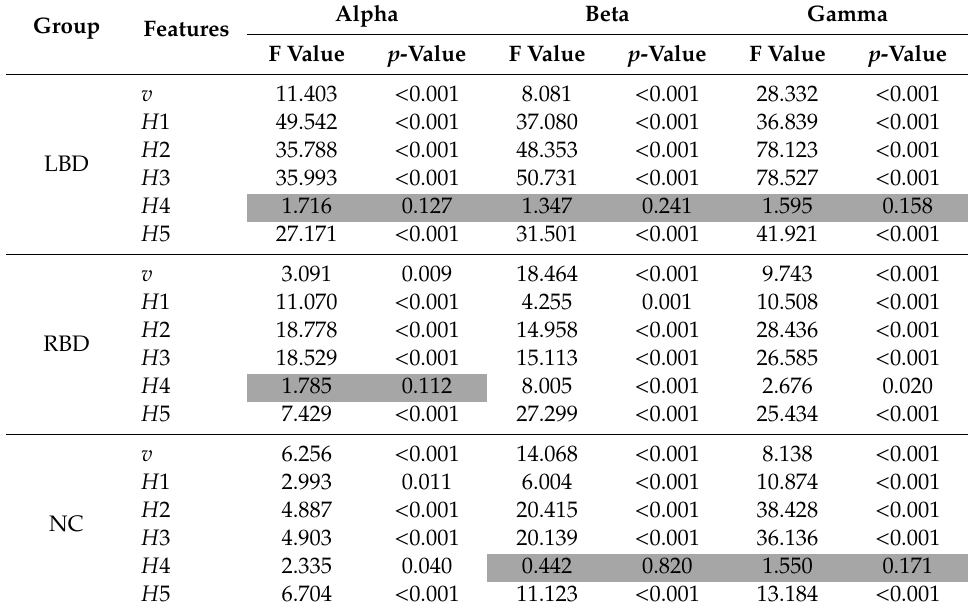
Table 2. Statistical validation results of LBD, RBD, and NC by using ANOVA (statistically significant at p ≤